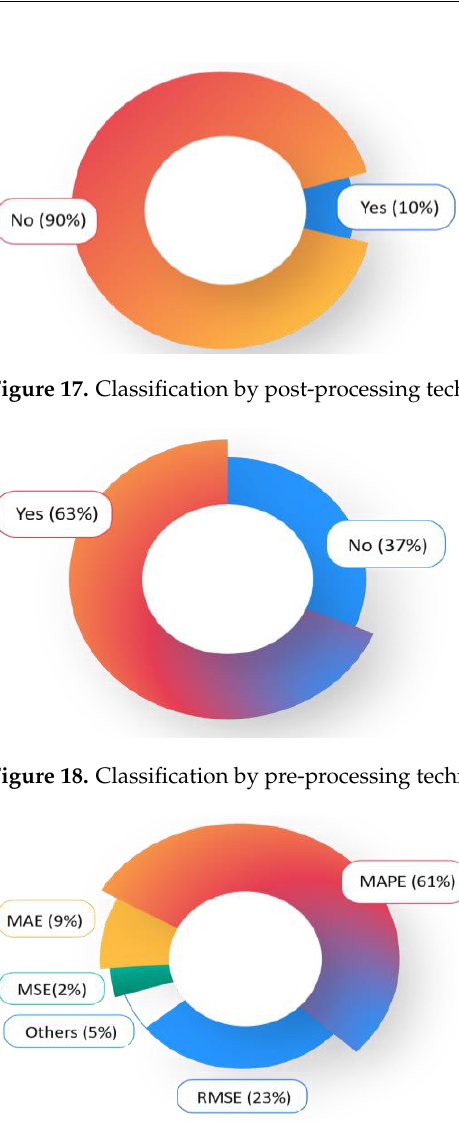
Figure 16. Classification by prediction horizon.